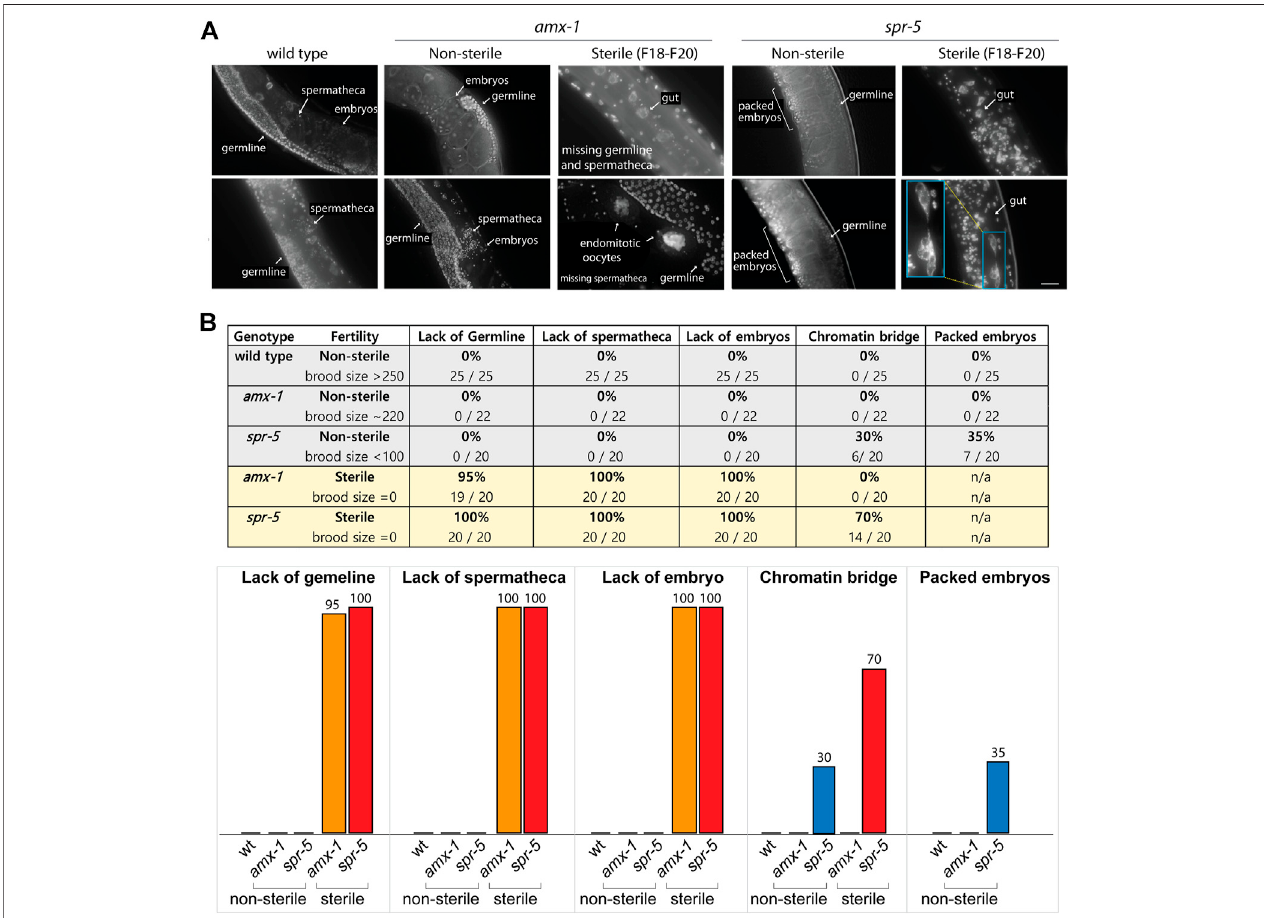
FIGURE 3 | Lack of AMX-1 leads to sterility with defective germline development. (A) Representative images of the worms exhibiting sterility. Wild type N2, non- sterile amx-1 and spr-5 are shown as control. While wild type and non-sterile amx-1 shows embryos, spermatheca and germline, sterile amx-1 mutants fail to exhibit germline nuclei or spermatheca, indicating the defective gamete development. Bar, 10 μ m. (B) Quanti fi cation of the phenotypic defects observed in whole worms without dissection. Inset (blue) shows an example of chromatin bridge of gut cells. Arrows indicate internal compartments of hermaphrodites. N > 20 worms for all